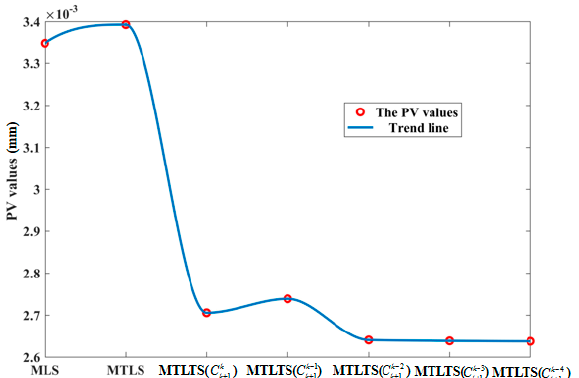
Figure 14. The PV value trend graph.